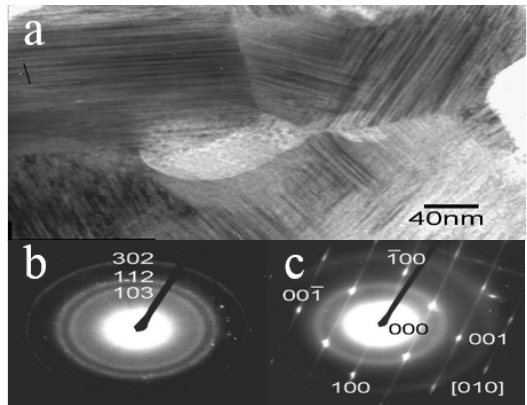
Figure 6. XRD pattern of the powder sample reduced by H 2 gas showing the sharpest Bragg peaks corresponding to the Miller indices of Fe 2 Mo phase.